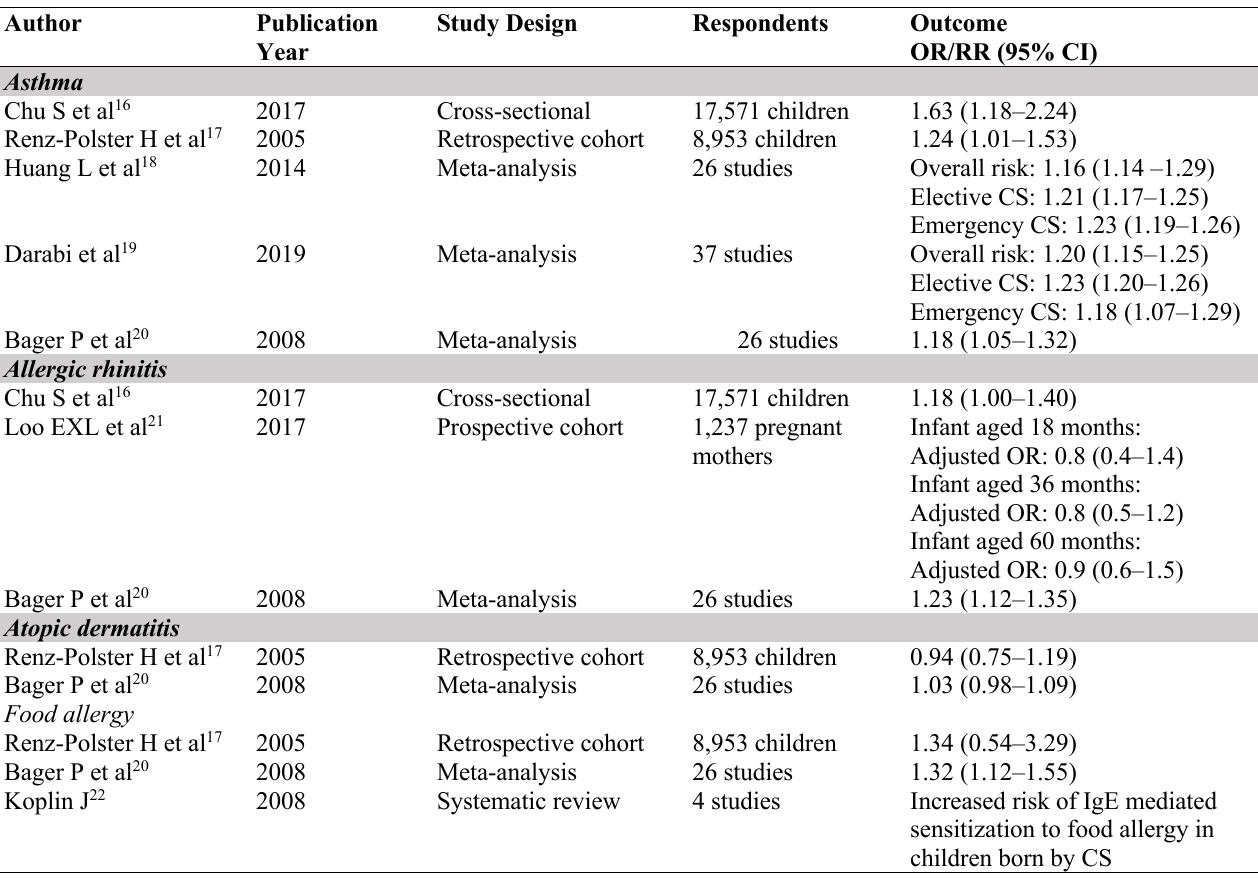
Table 1. Risk of Caesarean delivery on childhood